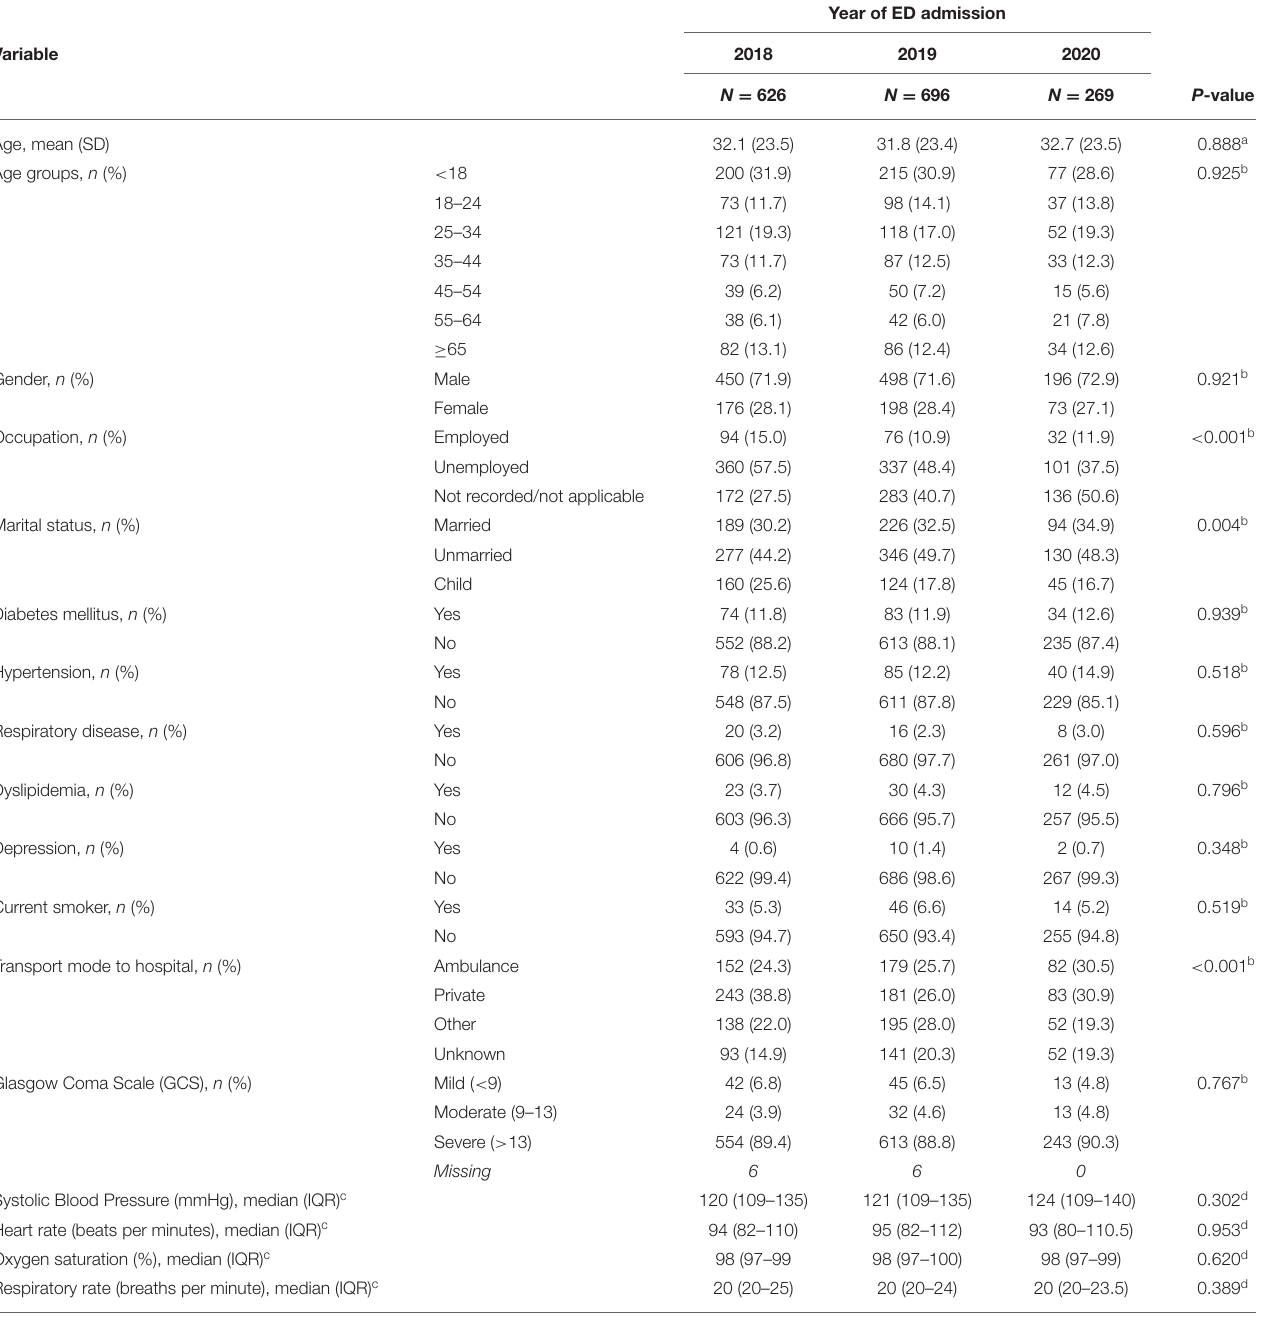
TABLE 1 | Demographic and clinical characteristics of patients presented in ED with